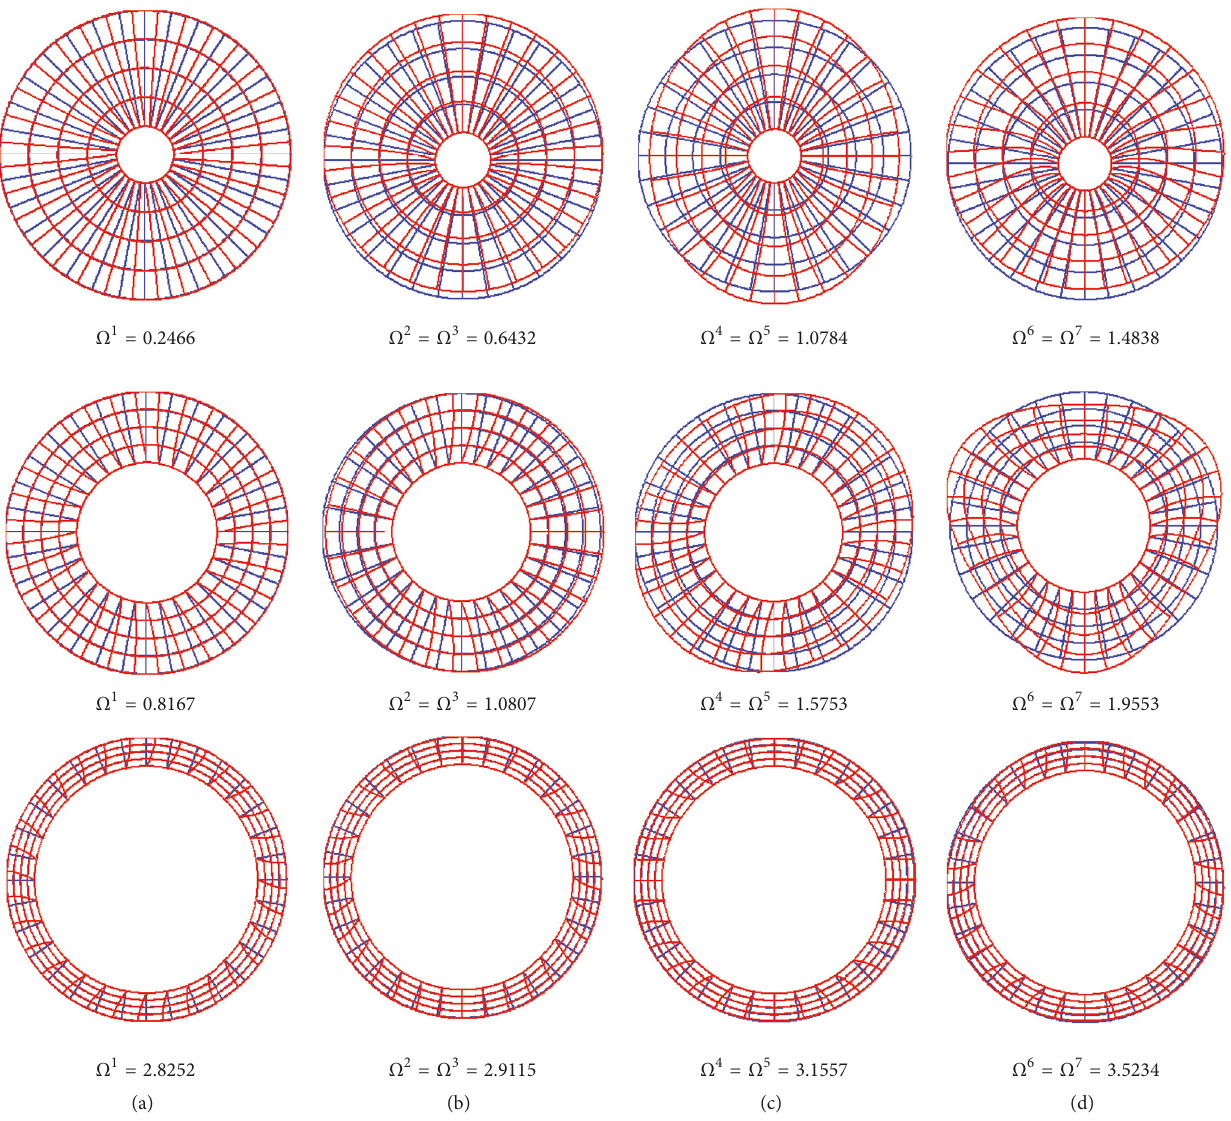
Figure 8: The first seven mode shapes of CF annular plate with different inner-to-outer radii ratios, that is, 𝑅 0 /𝑅 1 = 0.2, 0.5, and